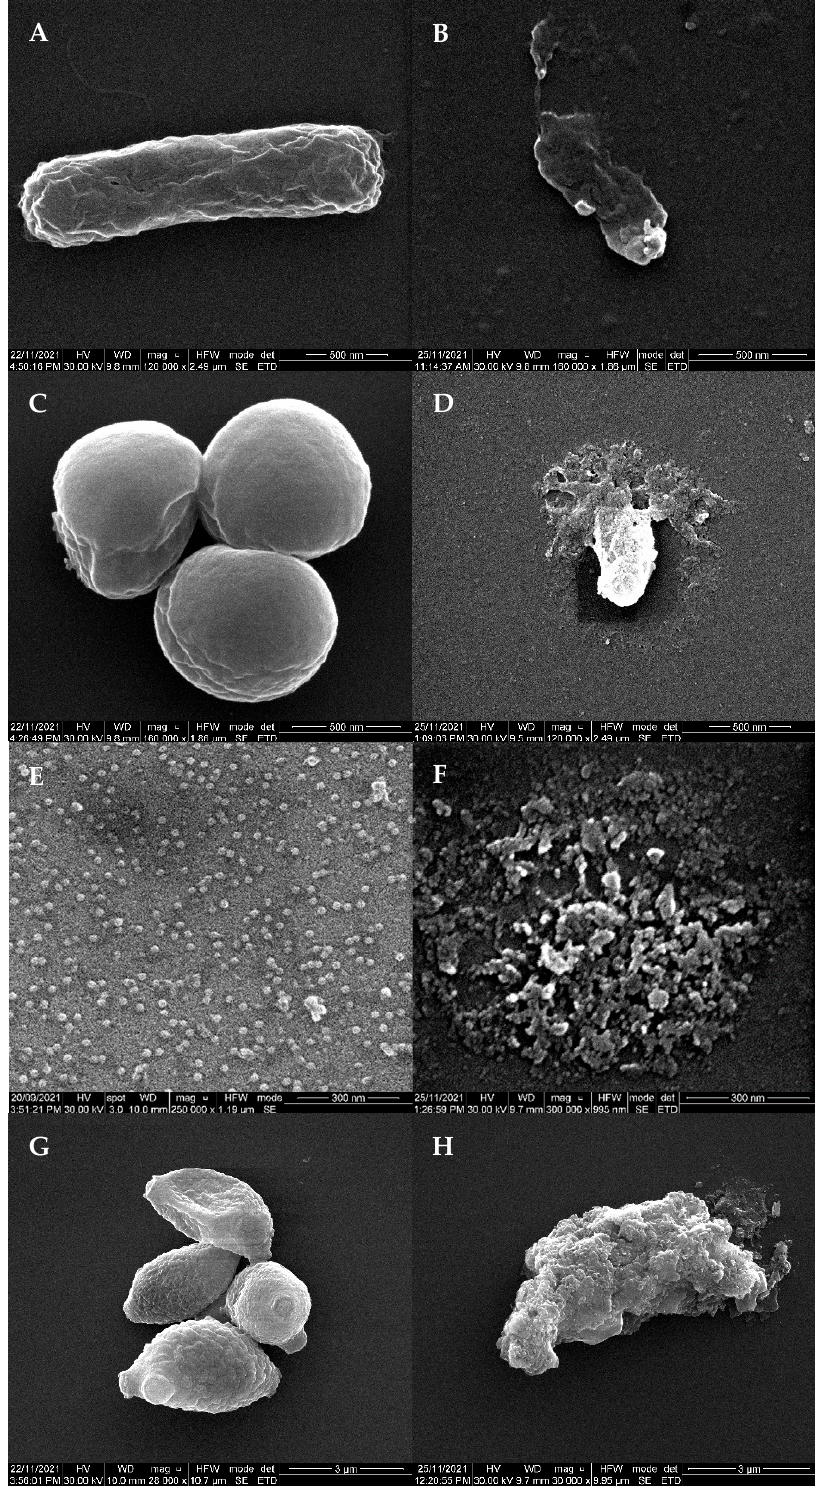
Figure 2. Scanning electron microscope images of baseline/negative control ( A ) E. coli ( C ) S. epidermidis ( E ) MS2 and ( G ) Cladosporium spp. and PlasmaShield ® destroyed microorganisms ( B ) E. coli ( D ) S. epidermidis ( F ) MS2 and ( H ) Cladosporium sp.